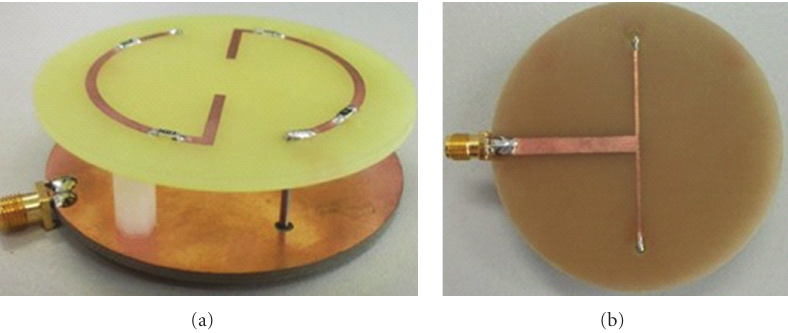
Figure 2: Photograph of the antenna: (a) 45 degree view of the antenna and (b) Bottom view of the antenna.